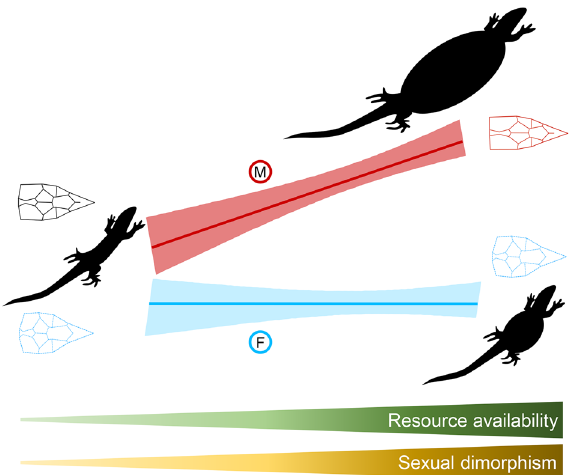
Figure 5. Condition and context-dependent expression of sexual dimorphism in Podarcis siculus . General trends of body size and head shape expression according to resource availability in males (M, red) and females (F,